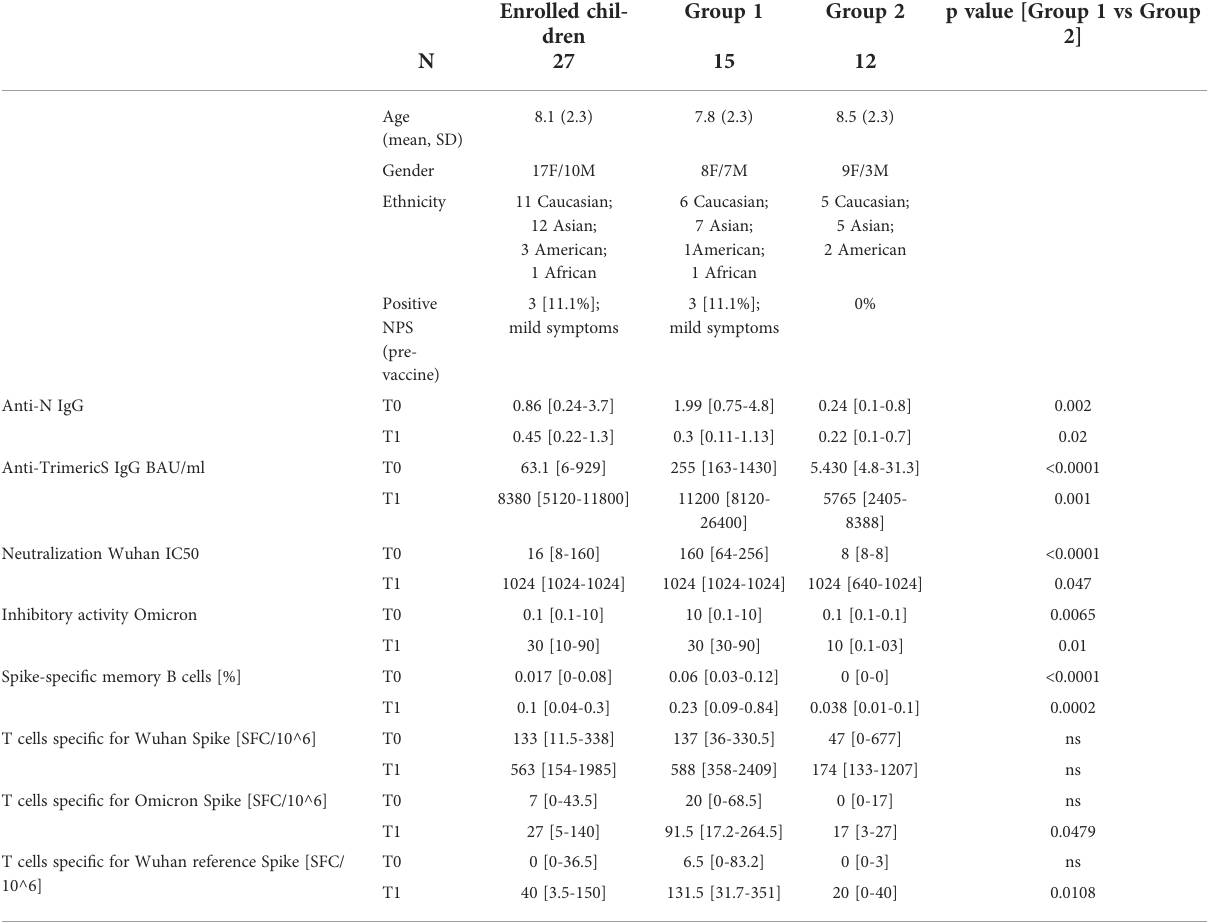
TABLE 1 Demographic and immunological characteristics of the enrolled